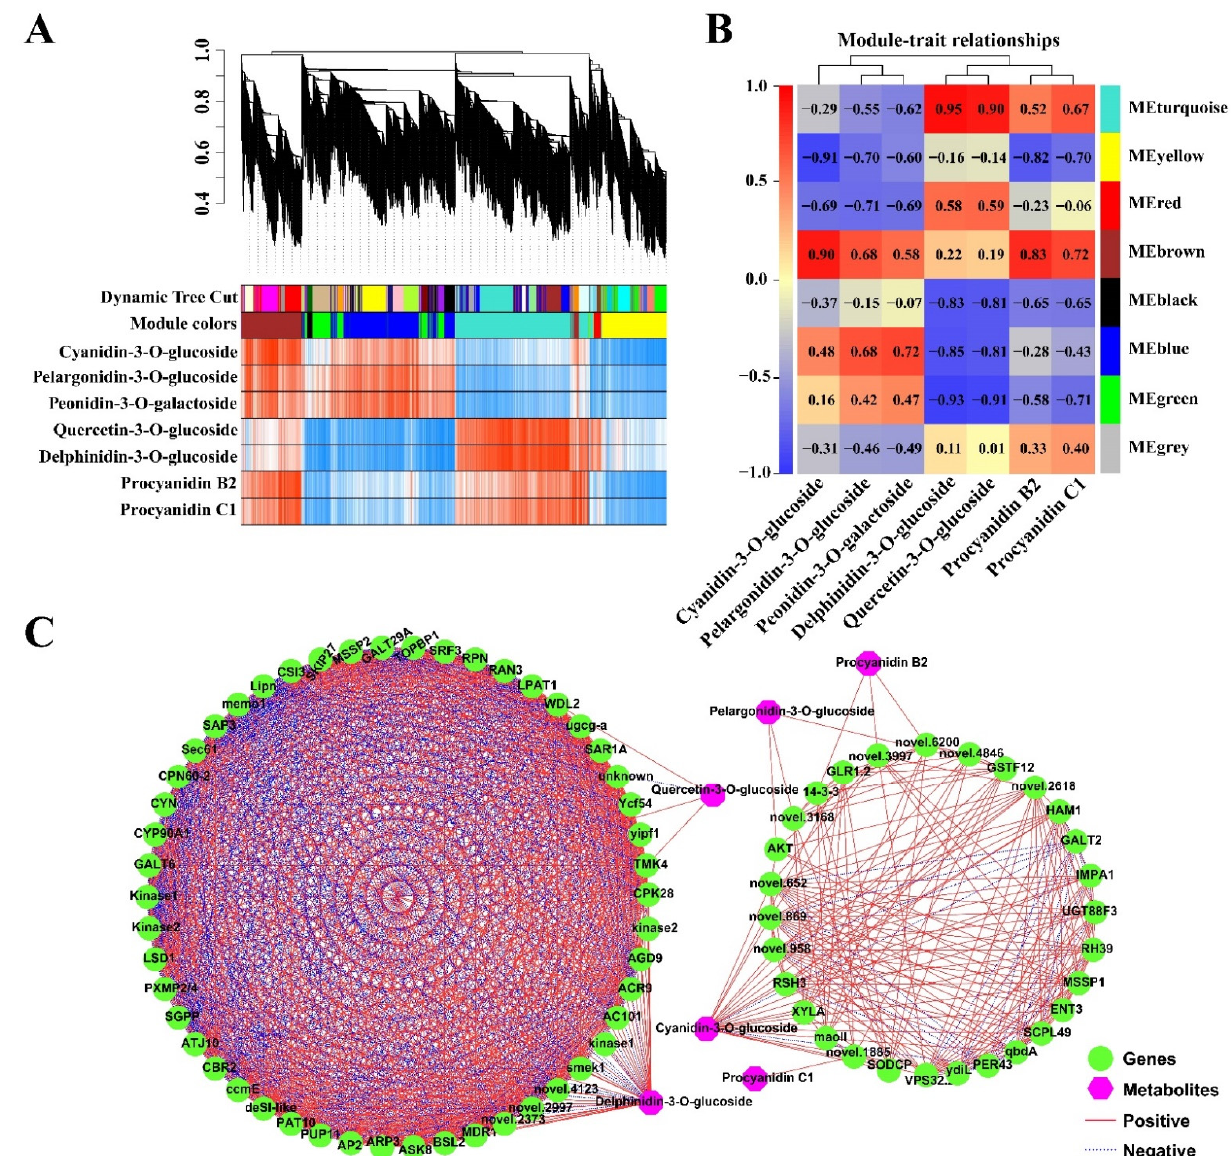
Figure 7. Weighted gene co-expression network analysis (WGCNA) of DEGs (with 7 metabolites, |PCC| ≥ 0.95) identified in pink and white petals. ( A ) Hierarchical clustering tree (cluster dendrogram) results showed eight expression modules, labeled with different colors. ( B ) Module– anthocyanin relationship analysis. The value inside each box represents Pearson’s correlation coefficient between the module with anthocyanin. The color scale on the left represents the degree of correlation between modules and anthocyanins and the red represent high correlation. ( C ) Connection network between DEGs and anthocyanin metabolites; the green ellipsoid represents DEGs; the pink diamond represents the metabolites. The red line indicates a positive correlation, and the blue dotted line indicates a negative correlation.